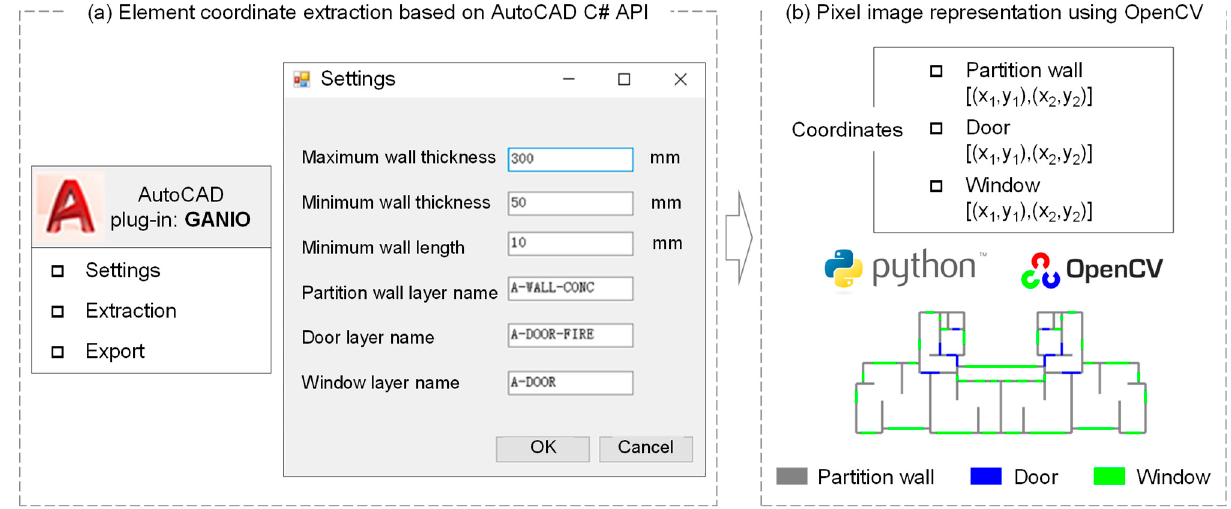
Figure 3. Preprocessing of architectural CAD drawings (the user interface of GANIO is in Chinese, and the figure is translated into English for convenient reading).